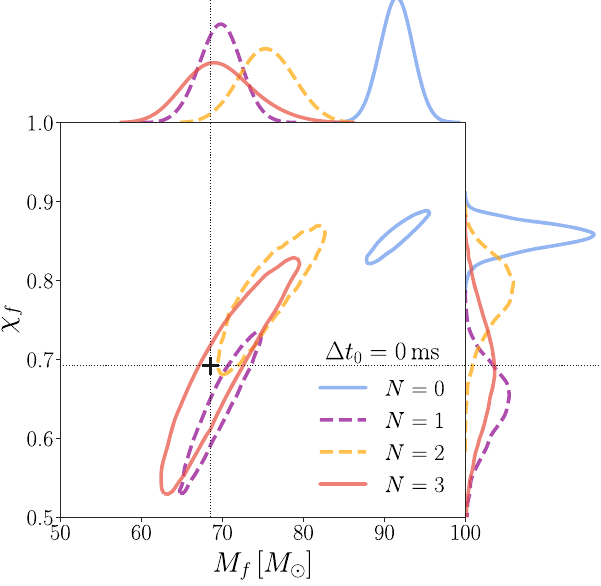
FIG. 11. Remnant parameters inferred using only the funda- FIG. 10. Remnant parameters inferred with different numbers mental mode, using data starting at different times relative to the of overtones, using data starting at the peak amplitude of the peak amplitude of the injected strain. Contours represent 90%- injected strain. Contours represent 90%-credible regions on the credible regions on the remnant mass ( M f ) and dimensionless remnant mass ( M f ) and dimensionless spin ( χ f ), obtained from spin ( χ f ), obtained from the Bayesian analysis of a GW150914- the Bayesian analysis of a GW150914-like NR signal injected like NR signal injected into simulated noise for a single into simulated noise for a single Advanced LIGO detector at Advanced LIGO detector at design sensitivity. For the blue design sensitivity. The inference model was as in Eq. (1), with contours, the inference model included no overtones ( N ¼ 0 ) and ð l ¼ m ¼ 2 Þ and different numbers of overtones N : 0 (solid used data starting at different times after the peak: Δ t 0 ¼ t 0 − blue), 1 (dashed purple), 2 (dashed yellow), and 3 (solid red). In t ∈ ½ 0 ; 3 ; 6 ; 10 (cid:4) ms (blue contours). For the red contour, the all cases, the analysis uses data starting at peak strain h -peak 0 ). The top and right panels show 1D analysis was conducted with three overtones ( N ¼ 3 ) starting at ( Δ t 0 ¼ t 0 − t h -peak ¼ the peak ( Δ t 0 ¼ 0 ), as in Fig. 10. The top and right panels show posteriors for M f and χ f , respectively. Amplitudes and phases 1D posteriors for M f and χ f , respectively. Amplitudes and phases are marginalized over. The intersection of the dotted lines marks are marginalized over. The intersection of the dotted lines marks the true value ( M f ¼ 68 . 5 M ⊙ , χ f ¼ 0 . 69 ). the true value ( M f ¼ 68 . 5 M ⊙ , χ f ¼ 0 . 69